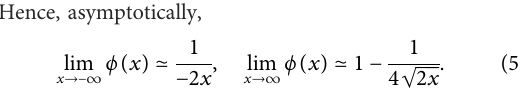
FIGURE 6 Potential given by Eq. 48 with n = m = 2 ( V 2,2 ), n = 2 m = 3 ( V 2,3 ), and n = 3 and m = 2 ( V 3,2